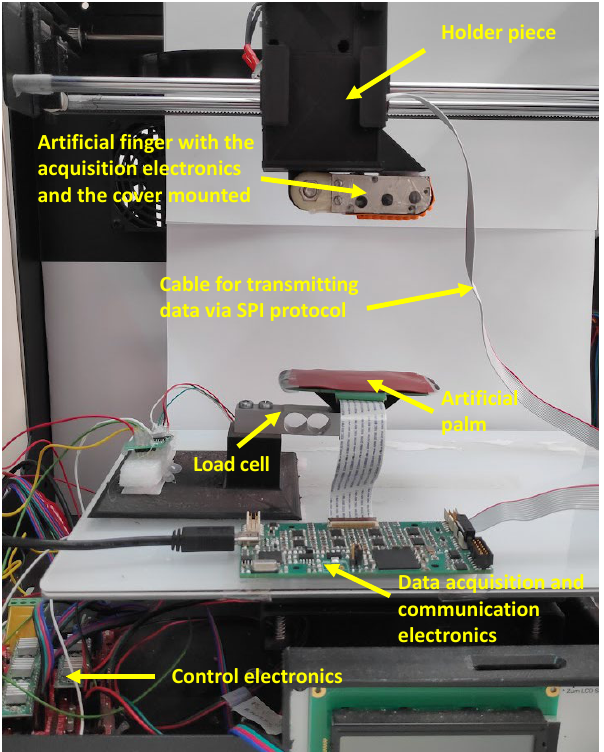
Figure 3. Experimental setup with the artificial finger and